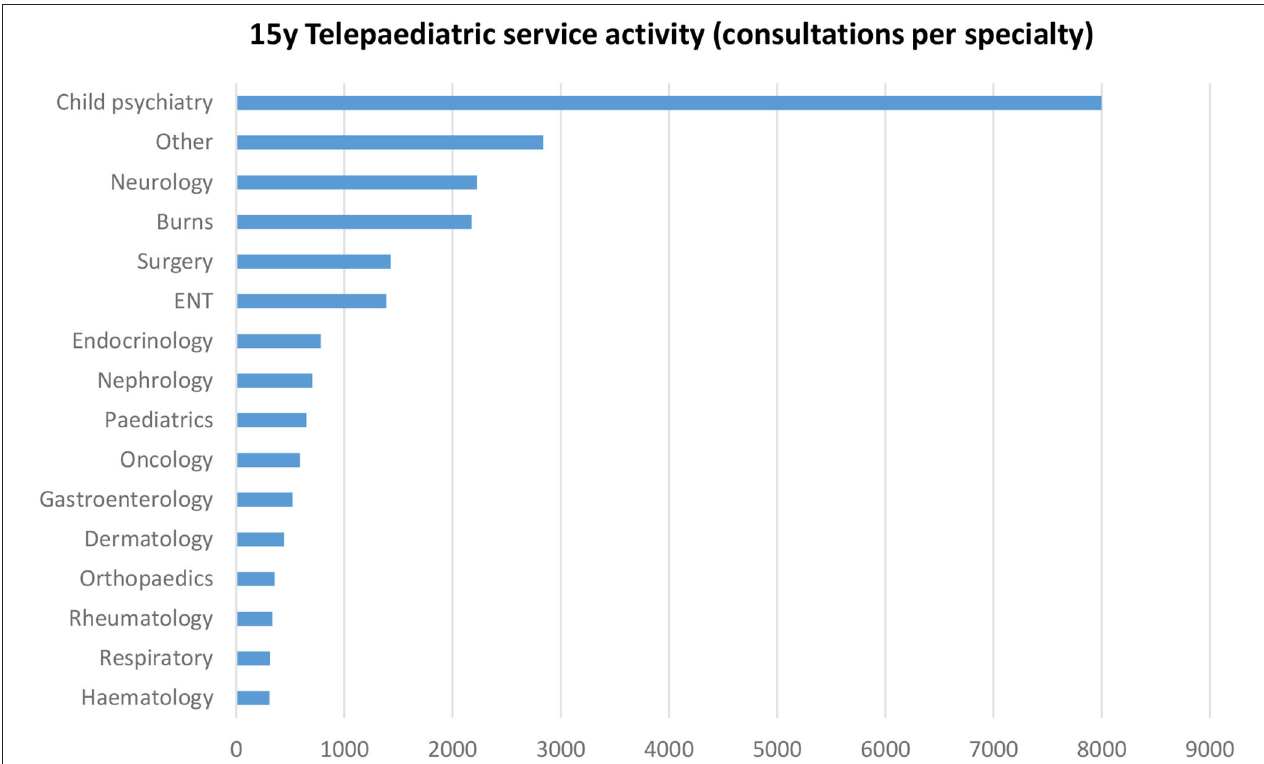
FIGURE 3 | Number of QTS consultations per specialty, from November 2000 to March 2016.